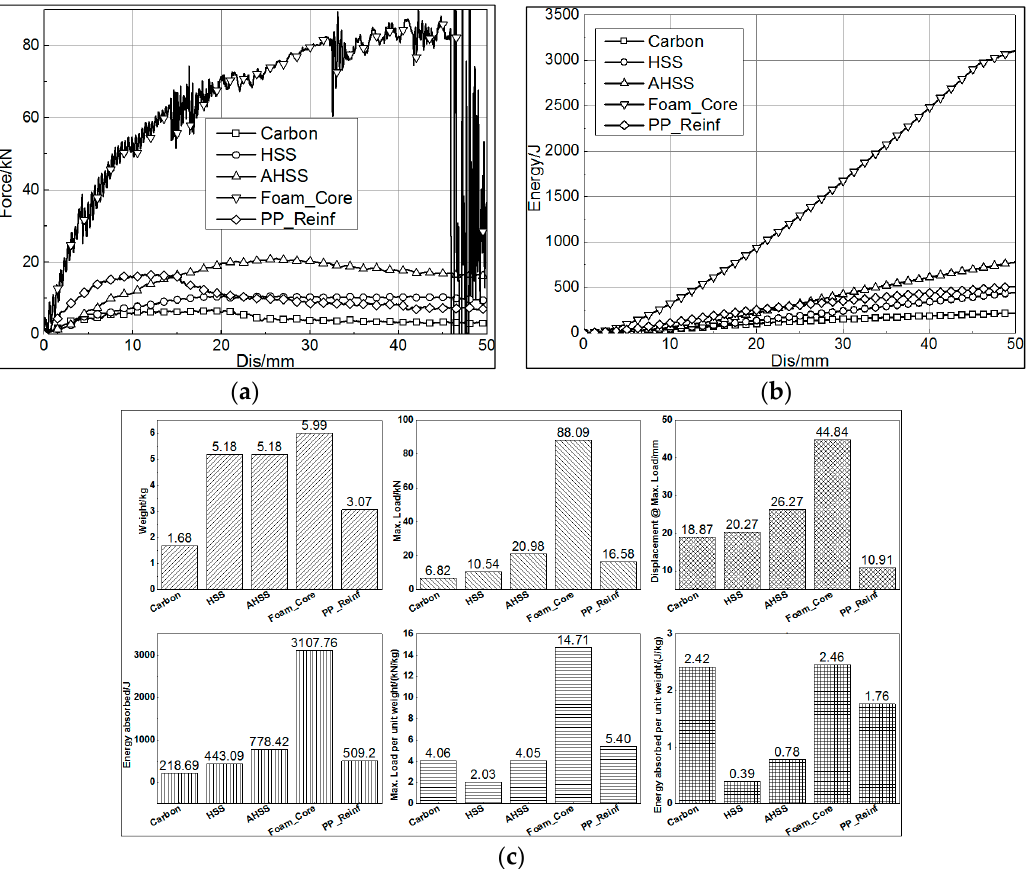
Figure 10. Comparison of the performance of different rocker panel components. ( a ) Force– Figure10. Comparisonoftheperformanceofdi ff erentrockerpanelcomponents. ( a )Force–displacement